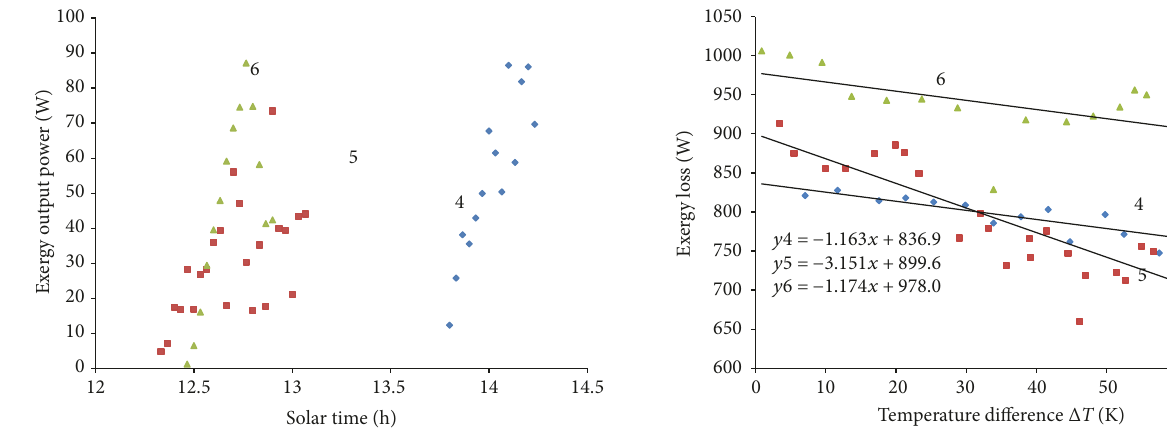
Figure 18: Exergy output power during the three experiments with 4kg of water load. Blue points correspond to experiment number 4, red to experiment number 5, and green to experiment number 6.